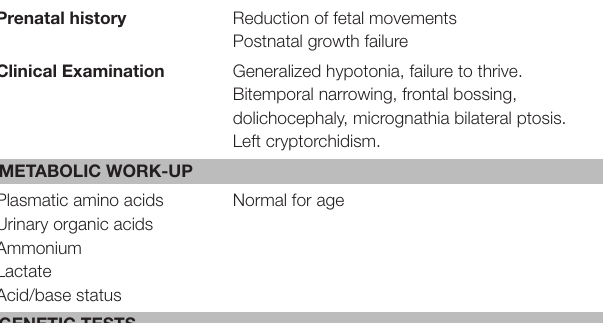
TABLE 1 | Clinical features and diagnostic work-up at